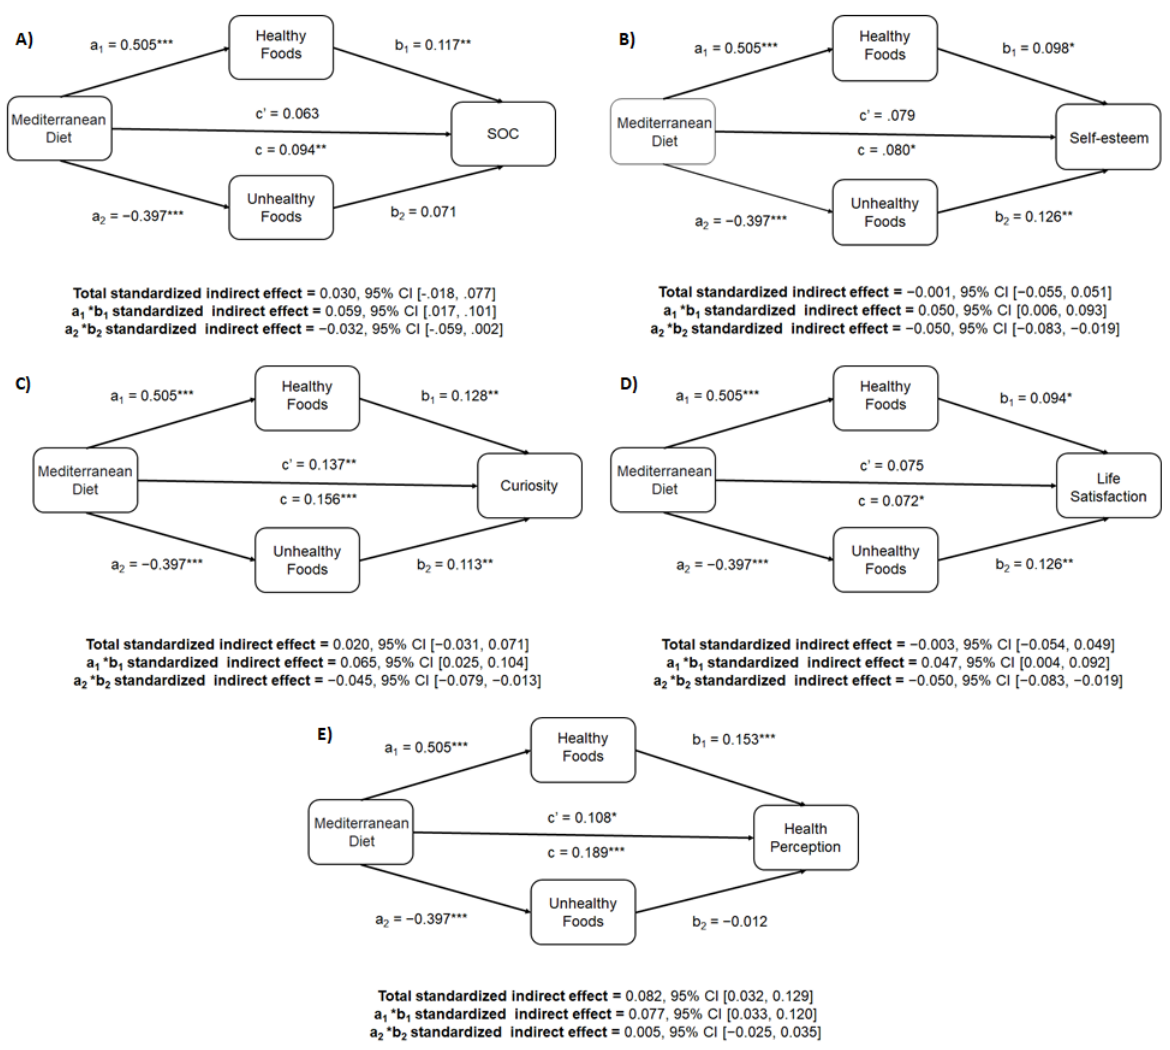
Figure 1. Mediation models of “healthy food” and “unhealthy food” consumption on ( A ) SOC, ( B ) self-esteem, ( C ) curiosity, ( D ) SWL and ( E ) perceived health. 95% CI: 95% Confidence Interval; * p < 0.05; ** p < 0.01; *** p <